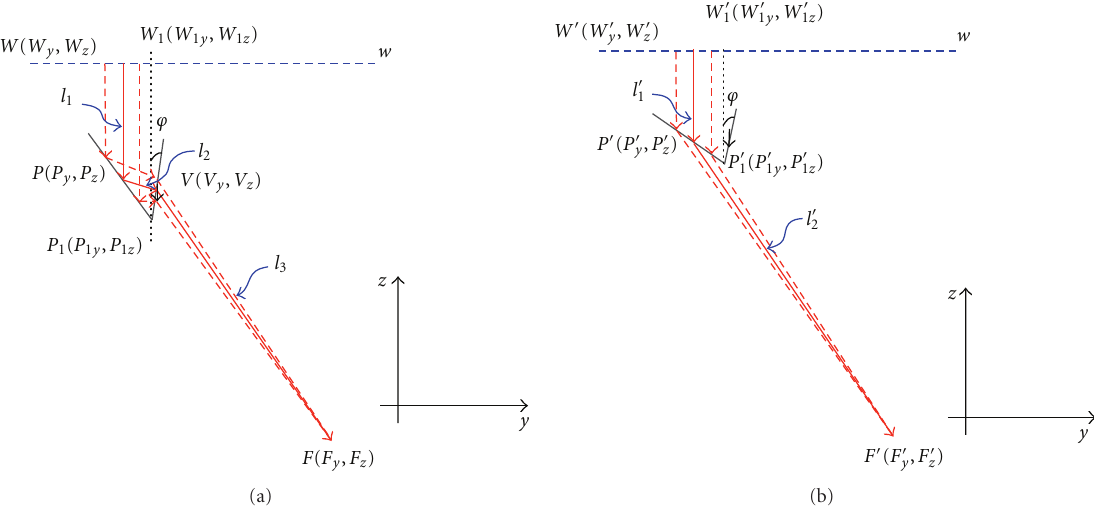
Figure 4: Design of the outer and inner sawteeth of primary Fresnel lens. The coordinate system is specified ( y , z ), where ϕ is the angle between the vertical surface and z -axis also named drag